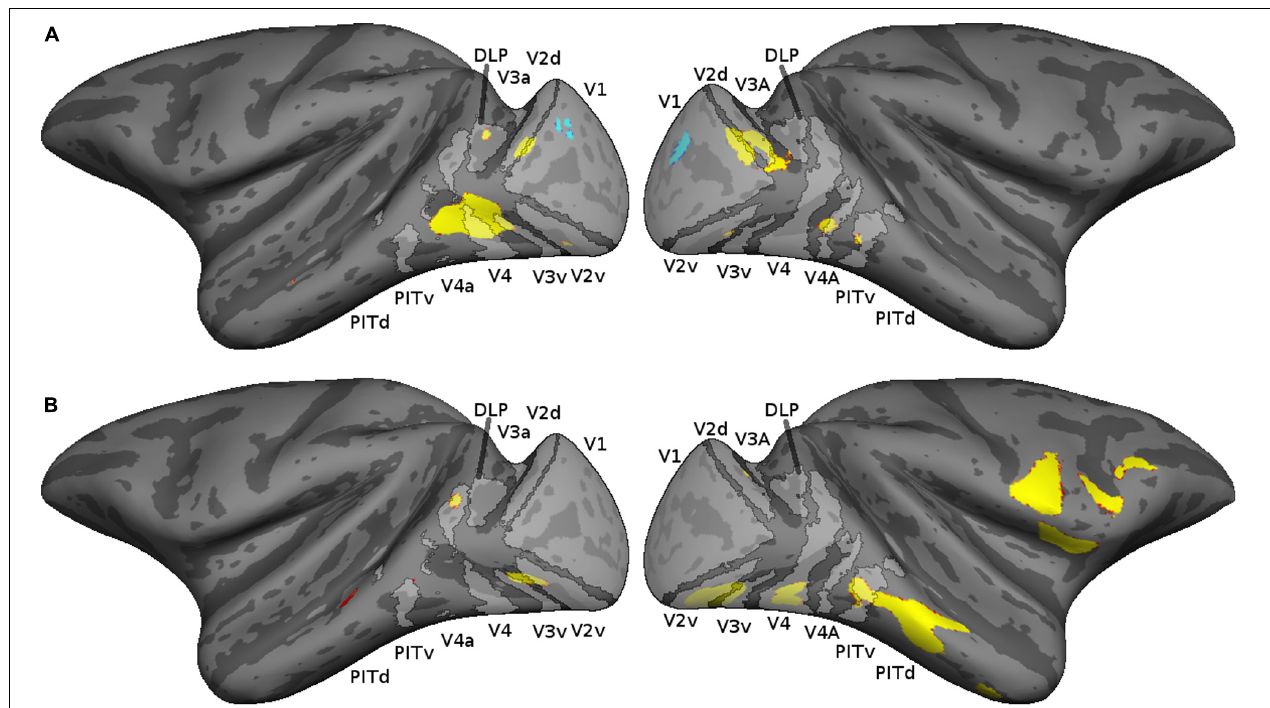
FIGURE 4 | Cortical activations shown on a probabilistic retinotopic map of the inflated F99 monkey brain. The thresholded retinotopic maps are indicated in light gray, using the definitions of retinotopic areas by Zhu and Vanduffel (2019). The thresholded cortical activations ( p < 0.05 family wise error rate) corresponding to the contrast random–regular are shown in red–yellow; those of the opposite contrast in blue. (A) M1, (B)